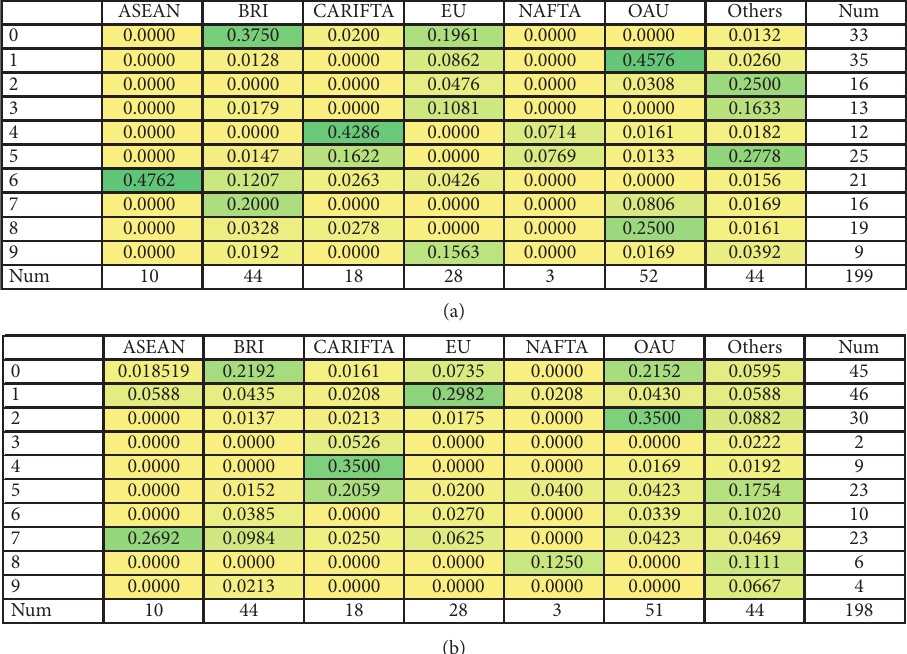
Figure 6: The similarity matrix between trade unions and trade communities in 2007 (a) and 2017 (b). “Num” means the number of members in the corresponding trade union or